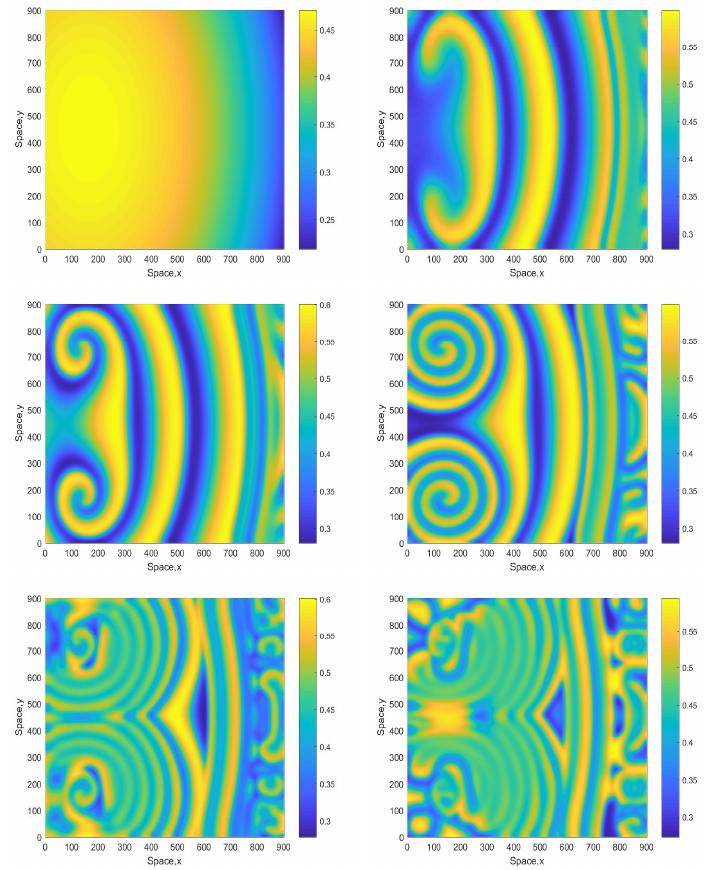
Figure 7. Spatial distribution of the oxygen concentration obtained for A = 2.04 in a larger domain 900 900 and shown for t = 1, t = 350, t = 500, t = 900, t = 1400 and t = 1600 (left to right, top to bottom). Other parameters are the same as above. The initial conditions are given by Equations (16)–(18) with c 0 = 0.4624, u 0 = 0.4290 and v 0 = 0.1293.